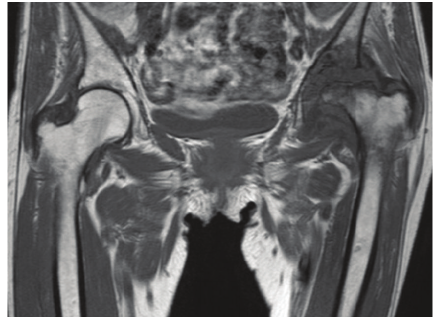
Figure 2: MRI T1WI at the time of admission to our hospital. Femoral head was completely collapsed and low band was observed in the upper edge of the femoral